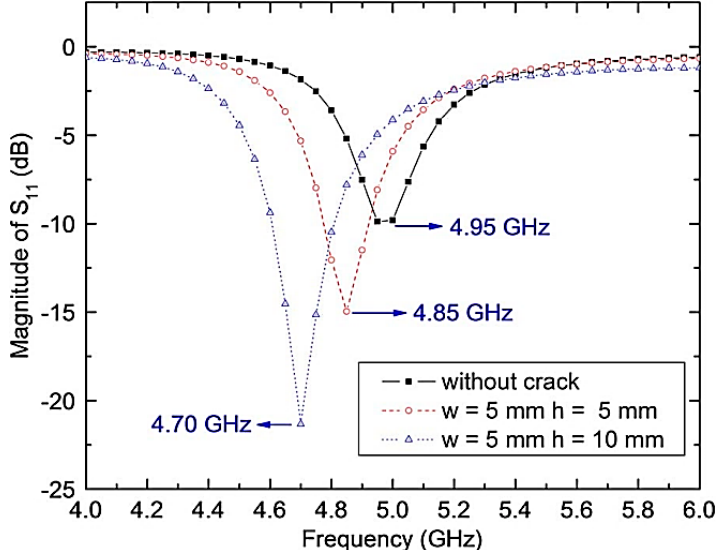
Figure 17. Re fl ection coef fi cient of the loop above perfect and defective aluminum boards. w and h are Figure 17. Reflection coefficient of the loop above perfect and defective aluminum boards. w and h the width and depth of the crack. w is equal to λ 0 /12, where λ 0 is the free ‐ space wavelength (i.e., 5 GHz). are the width and depth of the crack. w is equal to λ 0 /12, where λ 0 is the free-space wavelength (i.e., 5